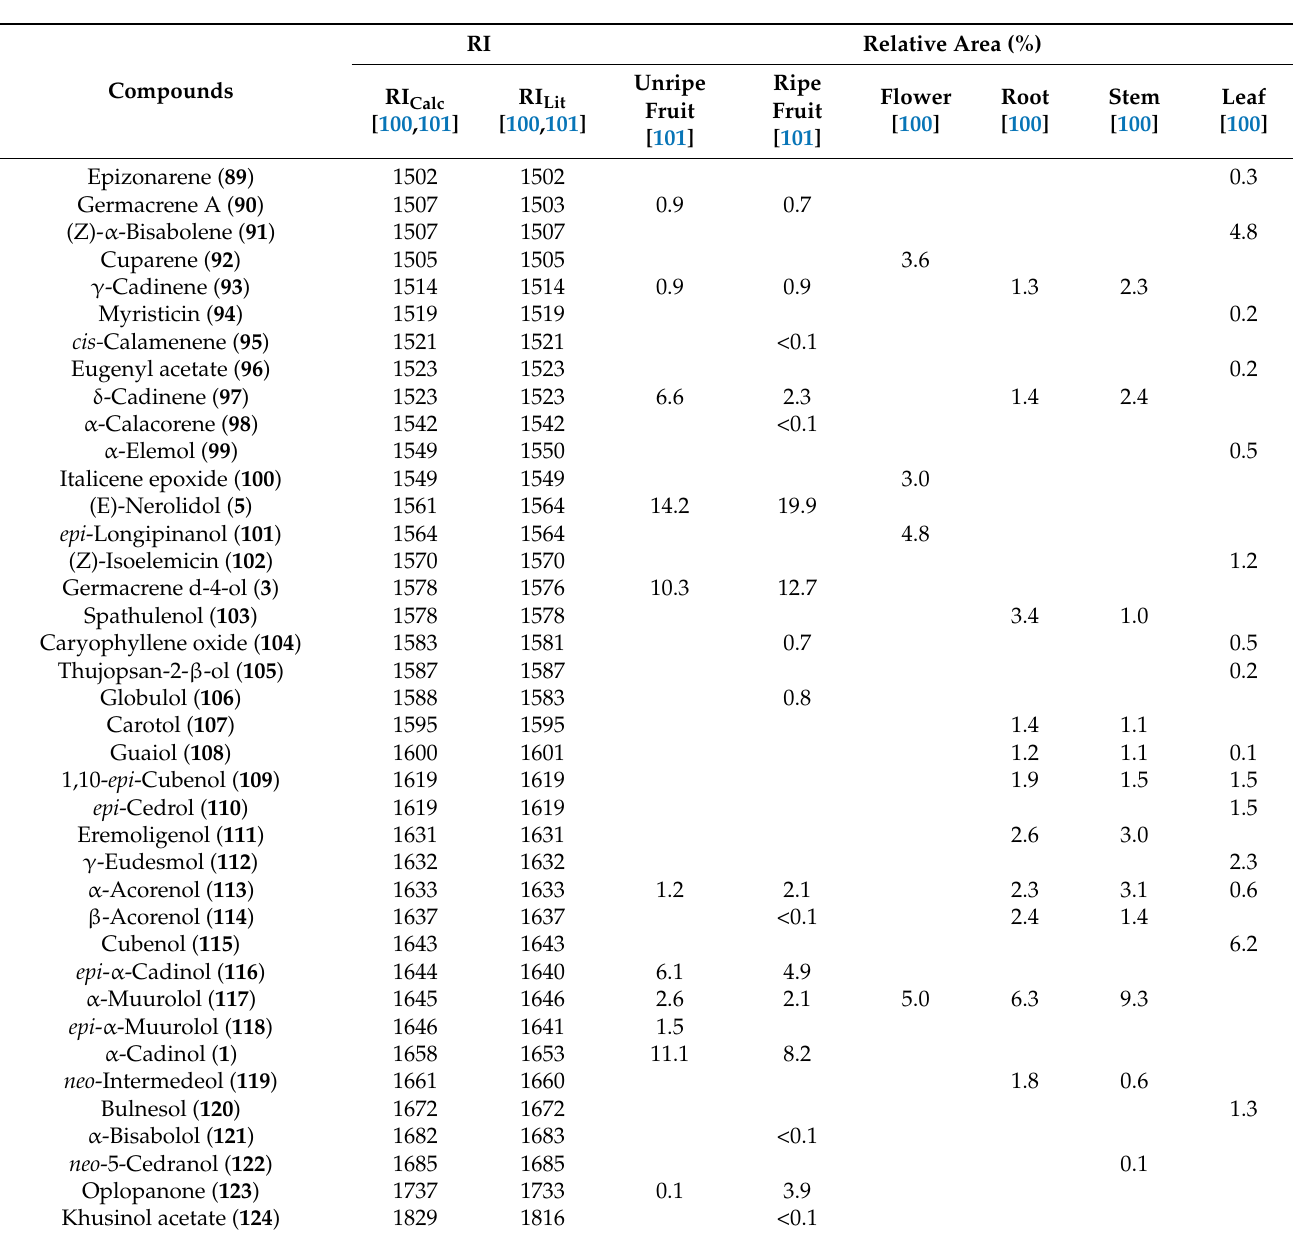
1829 1816 <0.1 RI cal = Retention indices relative (C 8 –C 26 ) and apolar DB-5 column ; Ri lit = Retention indices